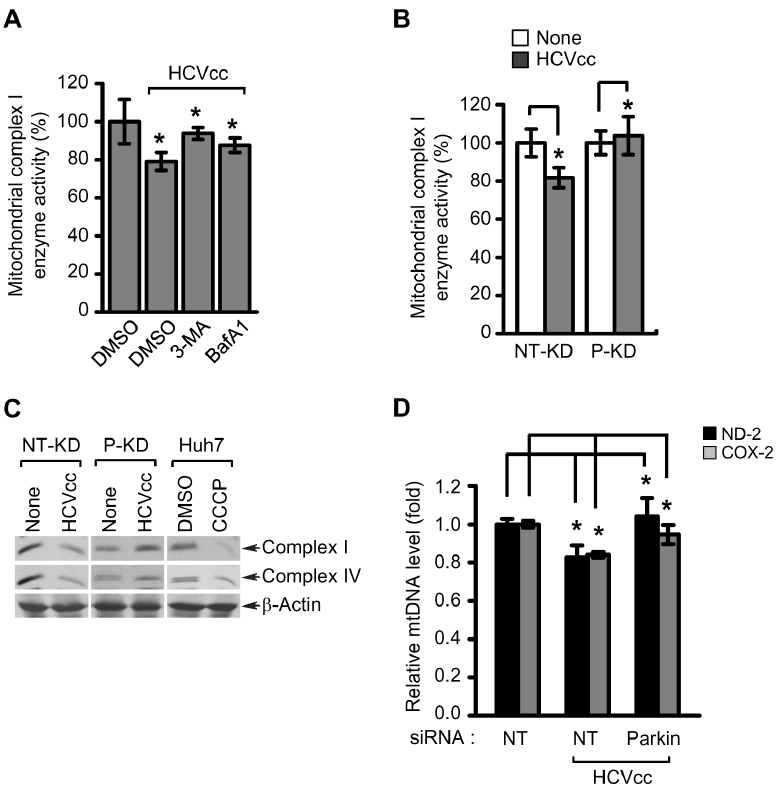
Figure 7. Mitochondrial functions altered by HCV infection are associated with Parkin-mediated mitophagy. ( A ) Rescue effect of 3-MA and BafA1 on reduction of mitochondrial complex I enzyme activity caused by HCV infection. Huh7 cells infected with HCVcc were treated with 3-MA (10 mM) or BafA1 (100 nM) for 12 h before harvest. At 3 days post-infection, the activity of mitochondrial complex I enzyme was measured according to manufacturer’s instructions (mean 6 SD; n=3; * p , 0.01). ( B ) Rescue effect of Parkin knockdown on reduction of mitochondrial complex I enzyme activity caused by HCV infection. NT-KD and P-KD cells infected with HCVcc were harvested on day 3 post-infection and used for analysis of the activity of mitochondrial complex I enzyme (mean 6 SD; n=3; * p , 0.05). ( C ) Western blot analysis of mitochondrial respiratory chain complex enzyme expression. NT-KD and P-KD cells were infected with HCVcc and at 3 days post-infection, the expression levels of complex I and IV enzyme were analyzed by immunoblotting with anti-Hu total OxPhos complex antibody. Huh7 cells treated with CCCP (10 m M) for 12 h were also analyzed as a control. b -actin was used as an internal loading control. P values were calculated by using an unpaired Student’s t-test. ( D ) Effect of Parkin silencing on depletion of mitochondrial DNA caused by HCV infection. Huh7 cells transfected with NT or Parkin-specific siRNA pools were infected with HCVcc. At day 3 post-infection, mitochondrial DNA levels of ND-2 and COX-2 were analyzed by real-time qPCR. GAPDH was used to normalize changes in ND- 2 and COX-2 gene expression (mean 6 SD; n=3; * p , 0.01). ( A , B , and D ) P values were calculated by using an unpaired Student’s